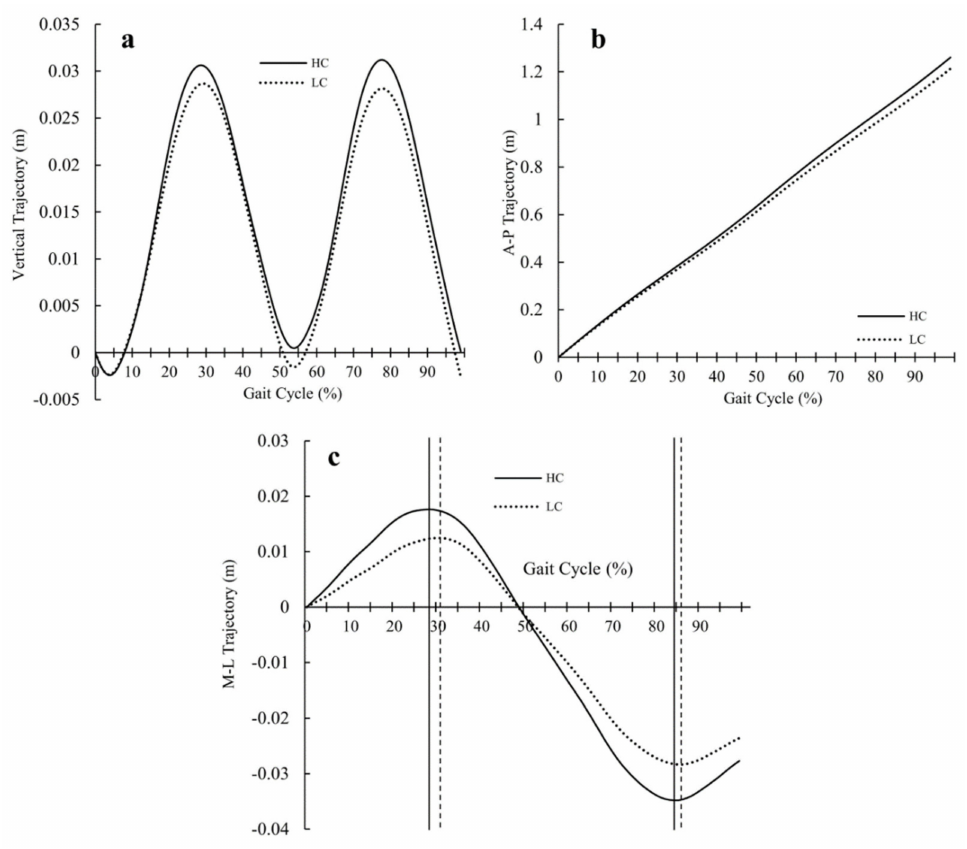
Figure 2. Average COM trajectory excursion graphs for LC and HC: ( a ) vertical trajectory graph, ( b ) anterior-posterior trajectory graph, and ( c ) mediolateral trajectory graph (the continuous and dotted vertical lines mark the peak occurrences for HC and